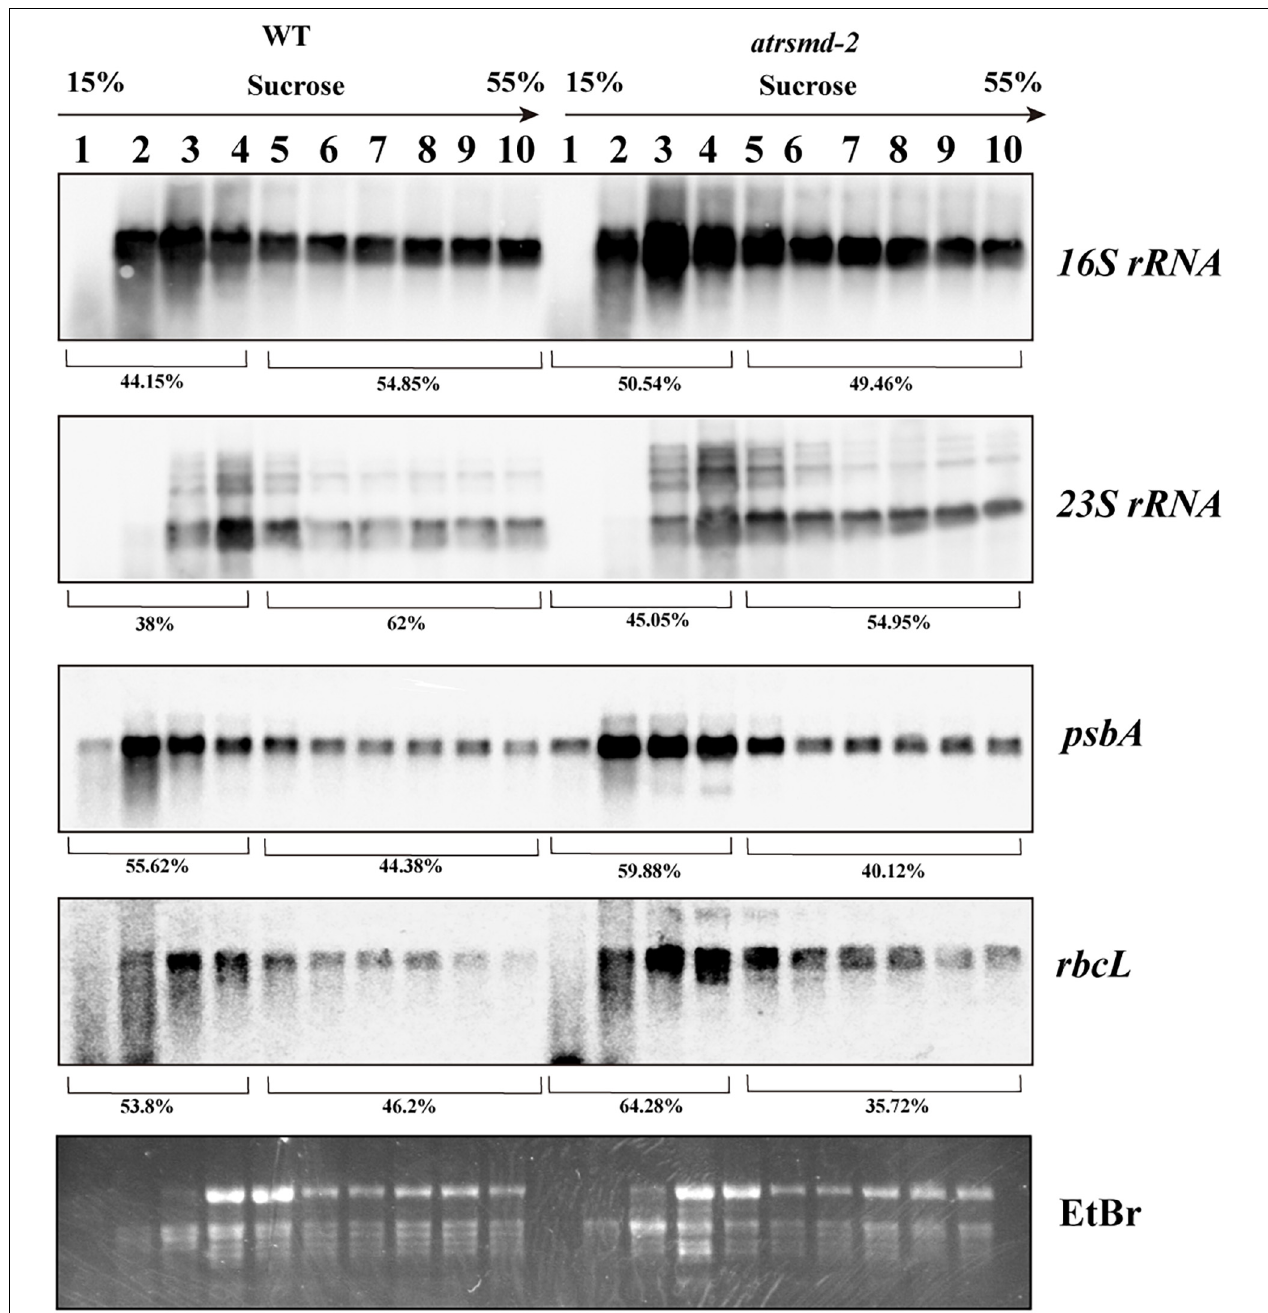
FIGURE 7 | Chloroplast polysome analysis in the wild type and atrsmd-2 mutant. RNA gel-blot hybridization of fractions obtained following sucrose density-gradient centrifugation under polysome-preserving conditions. Free ribosomes (monosomes) are found in fractions 1–4, whereas fractions 5–10 contain RNA-polysome complexes. Membranes were hybridized with probes specific for 16S rRNA , 23S rRNA , psbA , and rbcL . Ethidium bromide staining was used as a loading control. Signals of the polysomal fractions (fractions 1–4) and monosomal/free RNA fraction (fractions 5–10) were quantified with the ImageJ software, and their relative quantities were indicated as percentage of the total signal over the 10